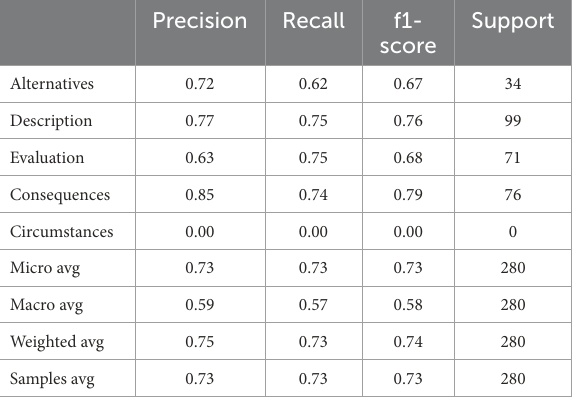
TABLE 3 Performance of ML-finetuned on test dataset from non- physics preservice